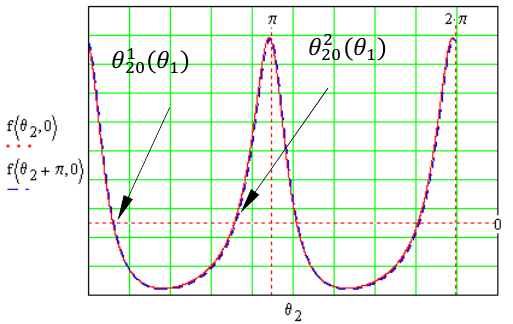
Figure 15. Plot of the rotation angle of the final element for a given constructive configuration and driving angle.